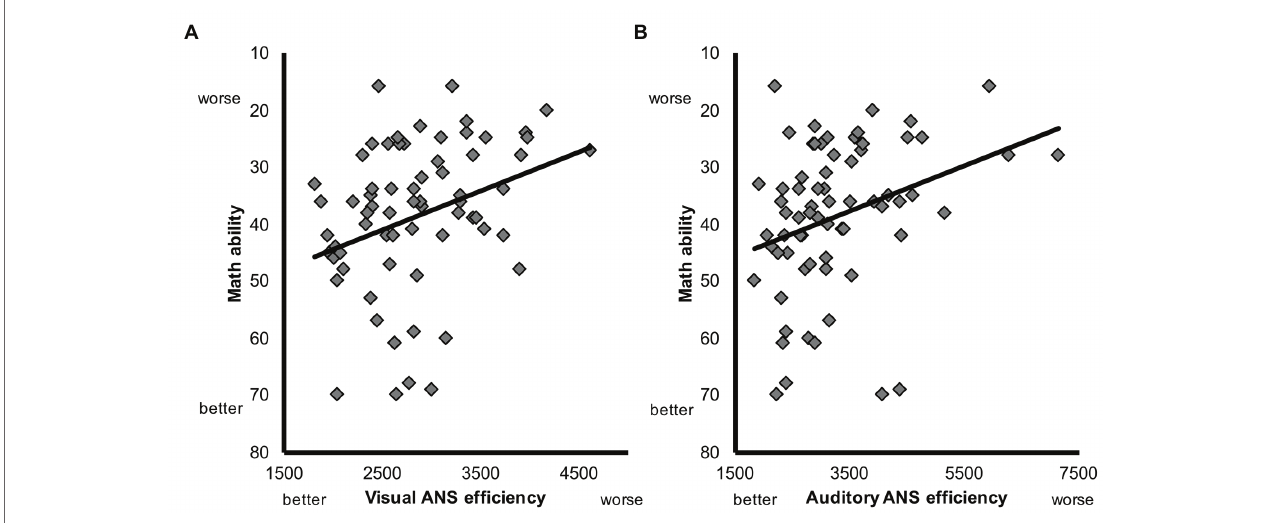
FIGURE 3 | Scatterplot depicting the relation between math ability [Test of Early Mathematics Ability (TEMA) raw score], (A) visual ANS efficiency, and (B) auditory ANS efficiency prior to training.